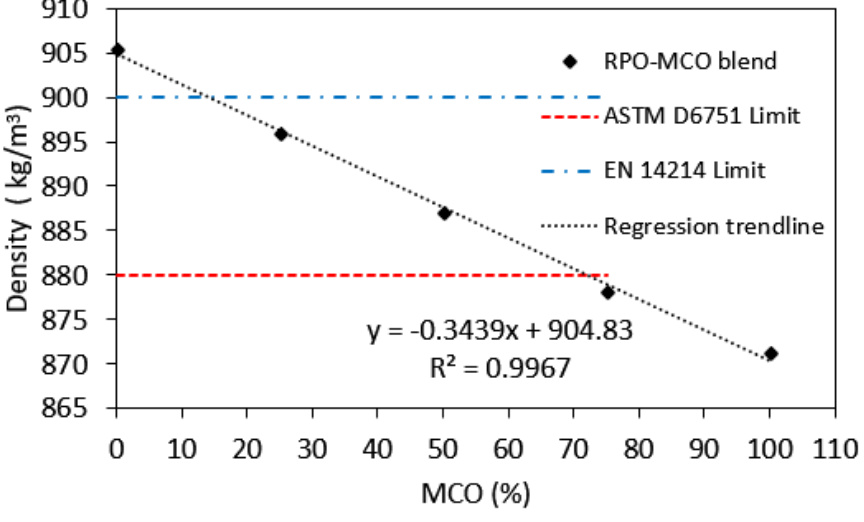
Figure 8. Correlation between MCO fraction and density. Table 5. Comparison between measured and calculated data of viscosity and density. Blend (vol.